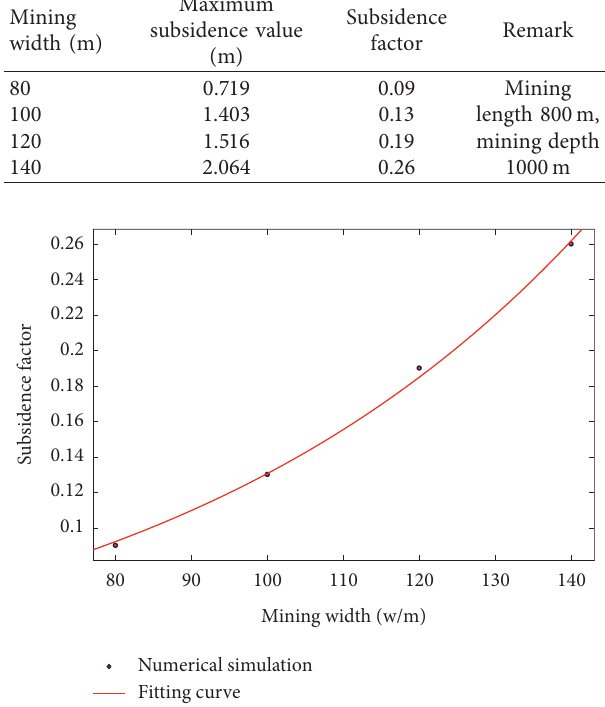
Figure 5: Relationship between the subsidence factor and the mining